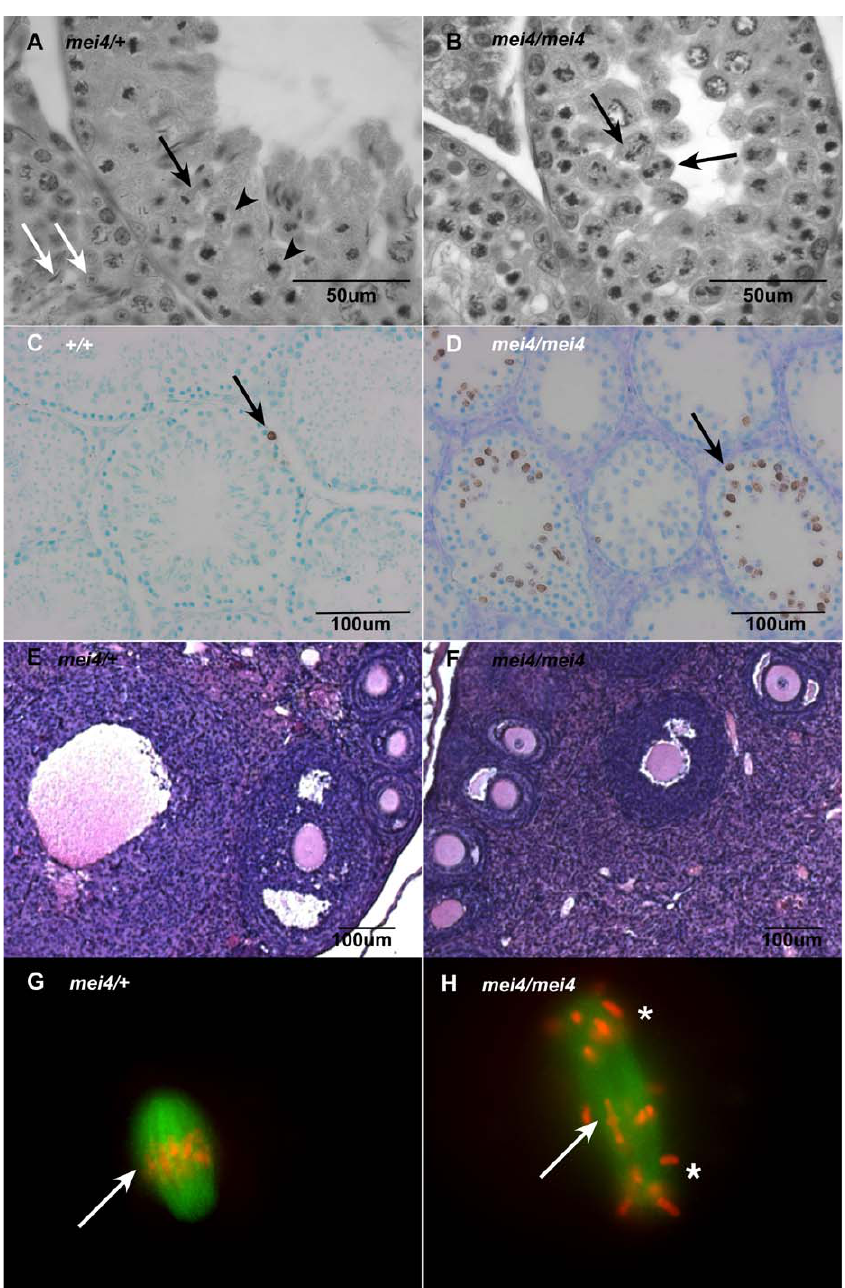
Figure 1. The mei4 Mutation Inhibits Normal Meiotic Chromosome Alignment at Metaphase I in Males and Females and Is Associated with Apoptosis in Spermatocytes (A) Heterozygous ( mei4/ þ ) seminiferous tubule cross sections stained with hematoxylin and eosin show normal telophase and metaphase I structures (black arrow and arrowheads, respectively) as well as postmeiotic round spermatids and elongating differentiating spermatids (white arrows). (B) Homozygous mutant ( mei4/mei4 ) sections show abnormal metaphase and anaphase I-like spermatocytes with disrupted chromosome congression to the metaphase plate and aberrant chromosome distribution on the spindle (black arrows). (C and D) mei4/mei4 mutant seminiferous tubules have significantly greater numbers of apoptotic cells (brown cell, black arrow) than þ / þ tubules (D versus C, respectively) as determined by TUNEL assay. The average number of TUNEL positive cells per 0.146-mm 2 field in tubules that contained apoptotic cells was 140 for mei4/mei4 versus 9.6 for þ / þ ( p ¼ 3.28 3 10 (cid:2) 15 ). (E and F) The ovaries of mei4/mei4 females appear histologically normal. Hematoxylin and eosin-stained cross sections reveal follicles and oocytes in all stages of development in normal (E) and mutant animals (F). (G and H) Hoechst-stained metaphase I chromosome structures occur normally in mei4/ þ oocytes (white arrow, G) and abnormally (asterisks, H) in mei4/ mei4 oocytes. Infrequently, normal metaphase chromosomes structures are seen in mutant oocytes (white arrow, [H]). Spindles in (G and H) are labeled with an anti-b tubulin antibody.